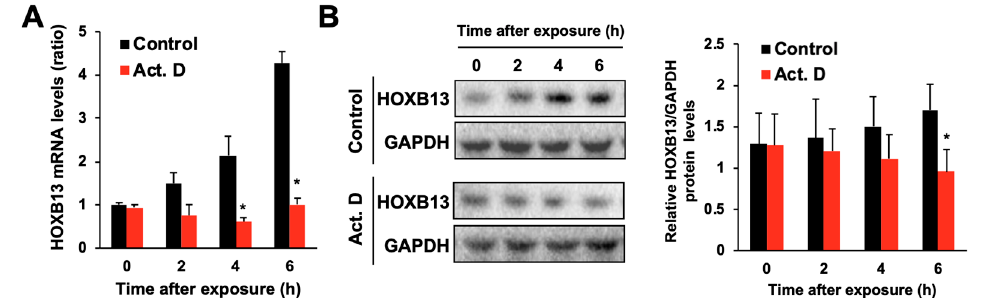
Figure 3. Effects of actinomycin D on the increase in the levels of HOXB13 expression by hydrogen peroxide. A549 cells were seeded onto 6-well plates for 24 h. Cells were exposed to hydrogen peroxide (400 µM) in the presence or absence of actinomycin D (Act. D; 1 µM). ( A ) The mRNA levels of HOXB13 and GAPDH were measured, and the relative values normalized to GAPDH are shown. ( B ) Left panel indicates immunoblots for HOXB13 and GAPDH proteins under the same conditions as in A. Right panel indicates densitometry analysis of the band intensity in the left immunoblot. All values are mean ± S.D. of three individual experiments. * p < 0.05 vs. control.